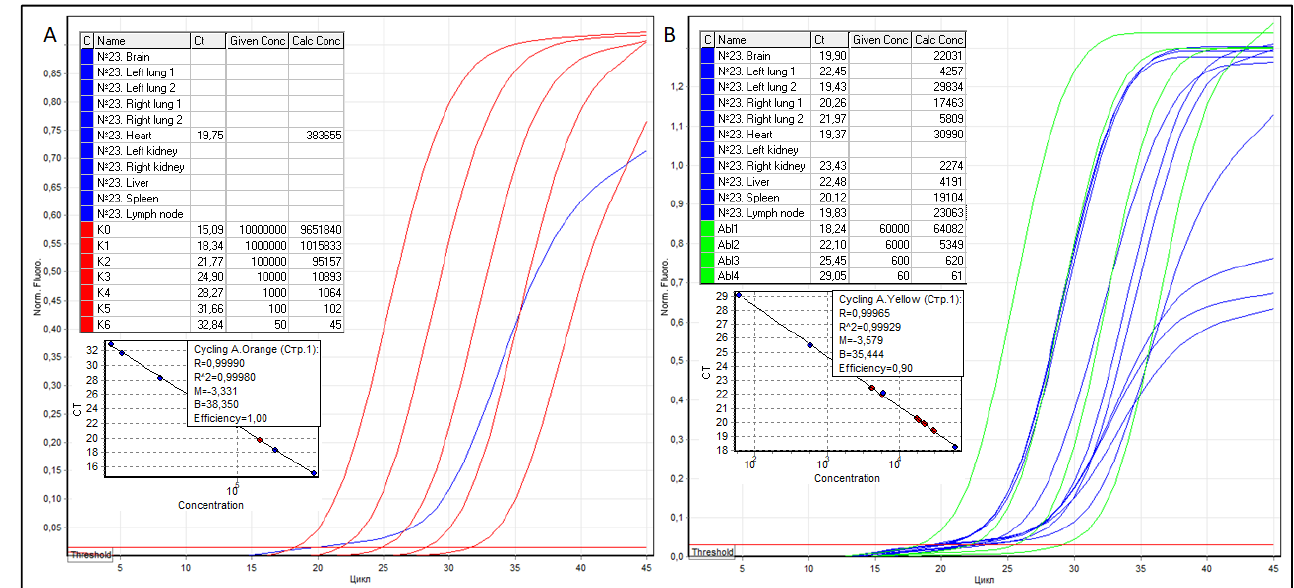
Figure 2. Threshold cycles (Ct), the concentration of serial dilutions of pGEM ® ‐ T Easy plasmids, the copy number of SARS ‐ CoV ‐ 2 ( A ) and ABL1 ( B ) cDNA, as well as graphical RT qPCR curves of patient No. 23. The samples are colored blue, SARS ‐ CoV ‐ 2 serial dilutions—red, ABL1 serial dilutions—green.